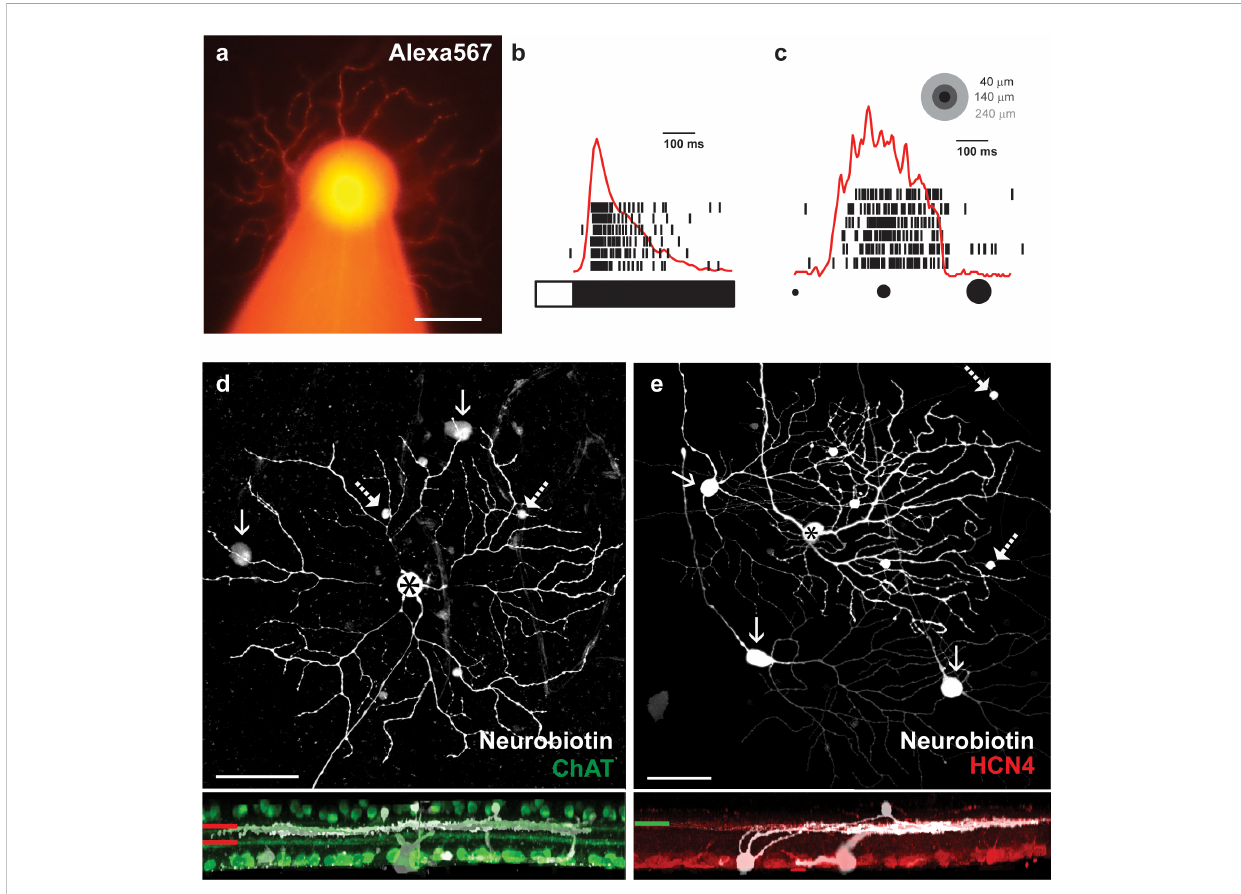
FIGURE 1 Identi fi cation of transient OFF alpha RGCs in the mouse retina. (A) Light microscopic image of an Alexa568-labeled OFF alpha RGC fi lled with a borosilicate glass pipette (visible as an out-of-focus structure at the bottom of the panel). (B) Spiking response of the alpha RGC (shown in panel A ) to photopic full- fi eld light stimuli. The bar on the bottom represents the duration (white) and the offset (black) of the stimulus, whereas the time stamps above represent individual responses of the targeted OFF alpha cell to six consecutive trials. The overlaid red curve is the peristimulus time histogram (PSTH) generated on the corresponding spike responses. (C) Spiking activity (black time stamps) and PSTH (red curve) of the OFF alpha RGC as a response to an approaching stimulus – a dark spot with an increasing diameter (from 40 m m to 240 m m in 0.5 s, equivalent of a 400 m m/s approaching movement, represented by the spots in the top right corner. (D) Face (top) and side (bottom) views of the result of the NB injection of the transient OFF alpha RGC (asterisk). The injected RGC and tracer-coupled nearby ACs (dashed arrows) and RGCs (arrows) are shown in white, whereas ChAT counter-labeled starburst cell processes and cell bodies are green. The ChAT-positive processes demarcate strata 2 and 4 (red lines to the left), and thus, the strati fi cation of injected and coupled neuronal processes (white) could be determined. Dendrites of stained neurons are clearly located right below the stratum 2 OFF starburst processes. (E) Face (top) and side (bottom) views of another NB-injected transient OFF alpha RGC (asterisk). The injected RGC and tracer-coupled nearby ACs (dashed arrows) and RGCs (arrows) are shown in white, whereas HCN4 counter- labeled type 3a OFF bipolar cell axon terminals are red (the green line represents the IPL strati fi cation level). The HCN4-positive processes clearly costratify with dendrites of the injected and coupled neuronal process (white). Scale bars in all images: 50 m